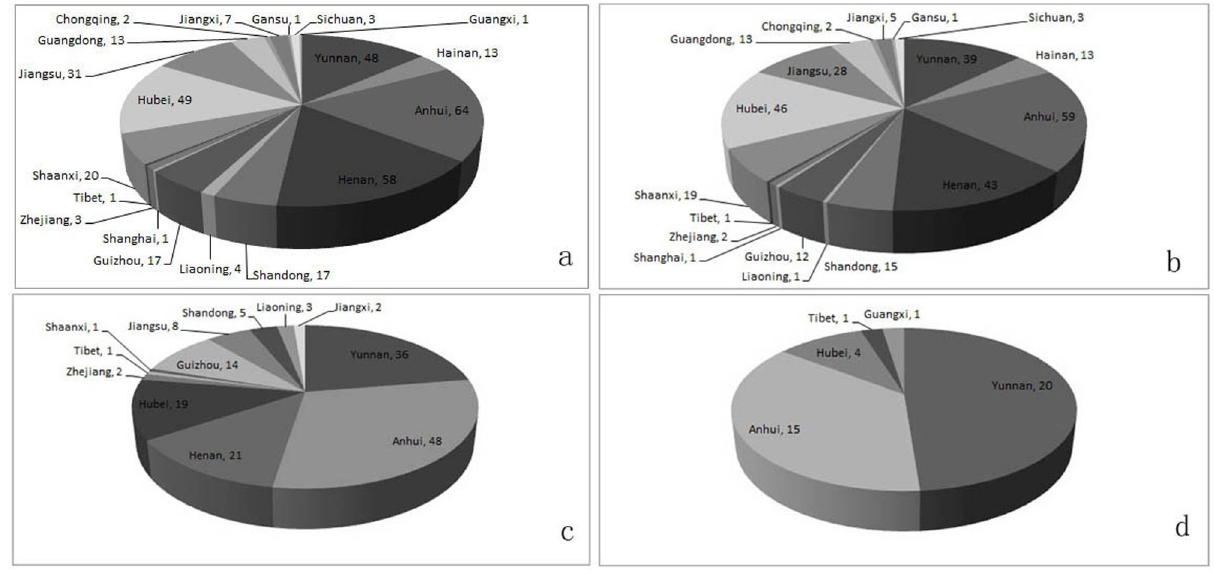
Figure 2. Distribution of Autochthonous Malaria at County Level in the Mainland of China, 2010-2012. a: distribution of total counties suffered from autochthonous malaria,2010-2012; b-d: distribution of counties suffered from autochthonous malaria in 2010, 2011 and 2012,